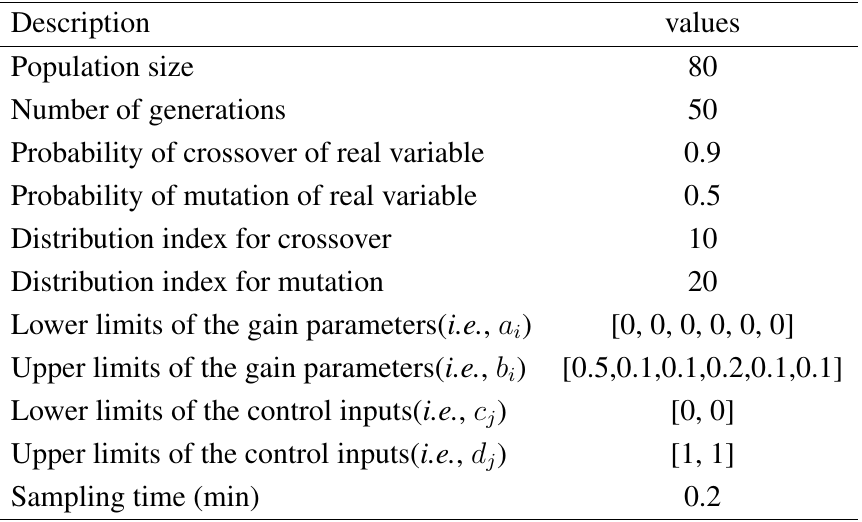
Table 2. Operators and parameters of real-coded NSGA-II.